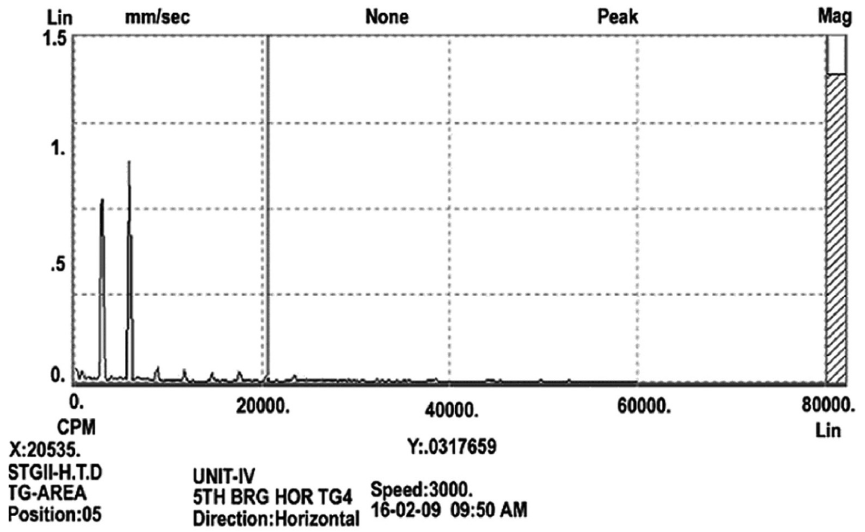
Fig. 2. Vibration spectrum that shows the maximum amplitude at odd of